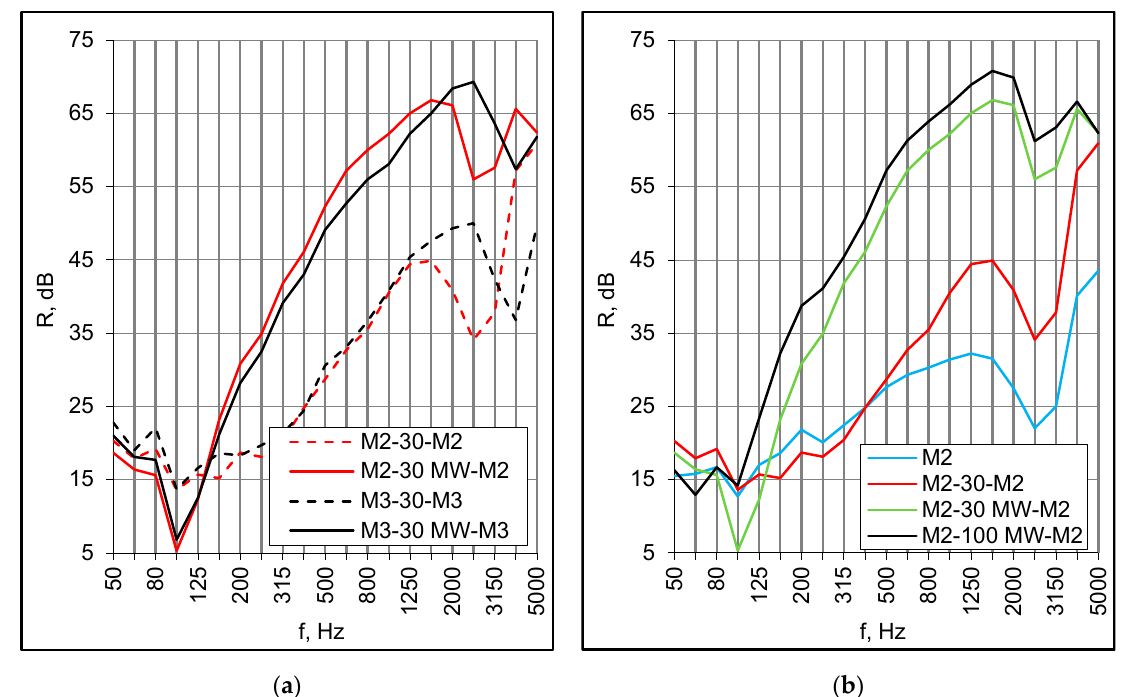
Figure 7. ( a ) Sound reduction index of double composite panels, the effect of mineral wool in the cavity; ( b ) Sound reduction index of M2 panels in different configurations, full-scale models.